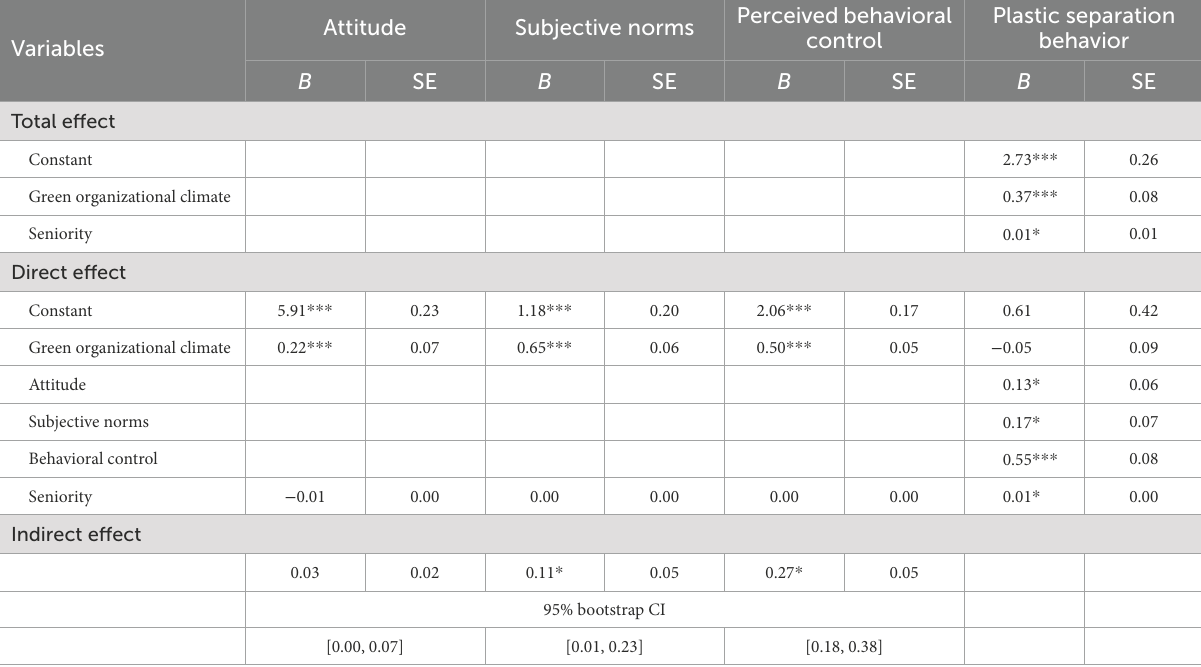
TABLE 5 Total, direct, and indirect effects for plastic separation.